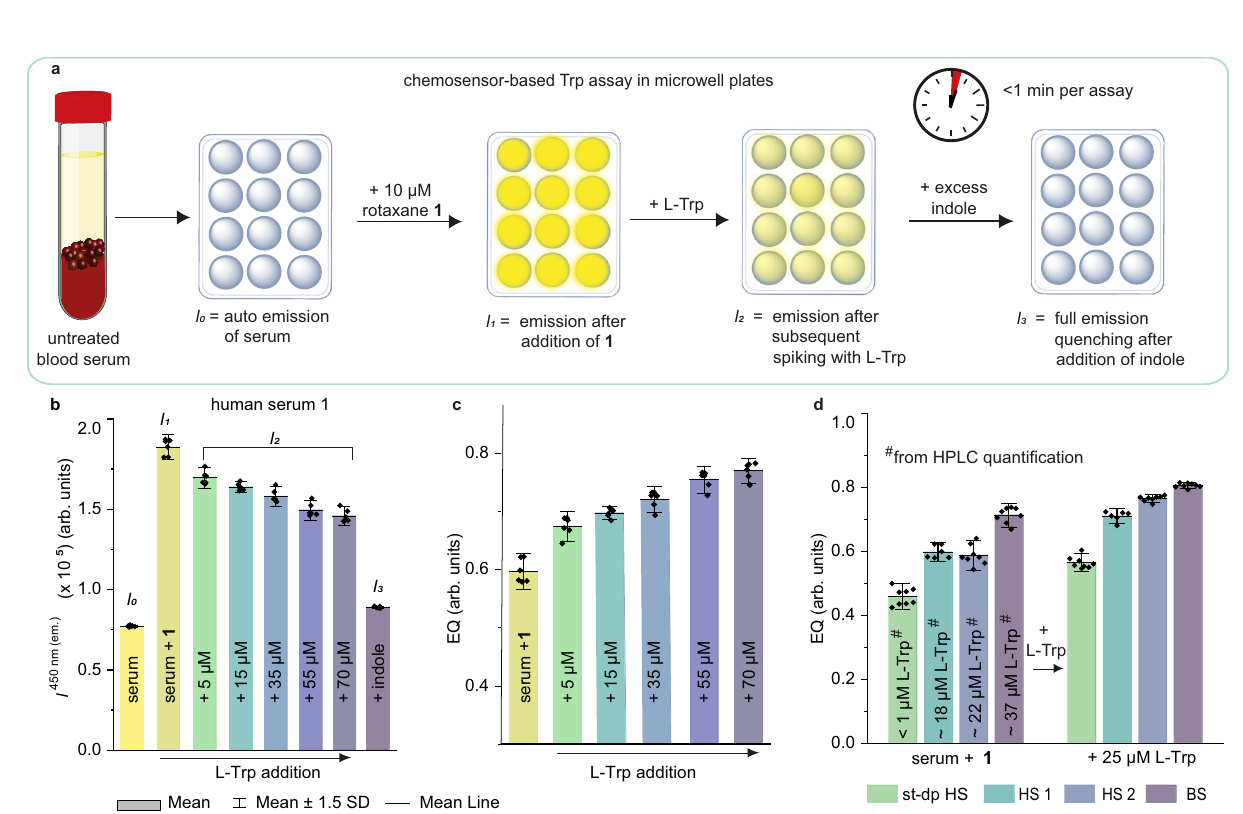
Fig. 5 | Tryptophan detection in untreated serum samples with rotaxane 1. a Schematic work fl ow for emission-based sensing of Trp with rotaxane 1 in untreated serum samples in a microwell plate format. b Bar graphs of the auto emission of human serum 1 ( I 0, yellow), the emission intensity of rotaxane 1 in human serum 1 ( I 1, light green), and the emission intensity of rotaxane 1 after additional spiking with5 – 70 µ M Trp ( I 2 , green to gray),and afterthe addition ofan excess of indole ( I 3, violet). The initial Trp concentration of human serum 1 was 18 µ M, and thetotal Trp concentration testedranged from 18to 88 µ M throughout the assay, measured in n =6 independent replicates. c Bar graphs of the emission quenching of rotaxane 1 in human serum 1 (light green) and after quantitative